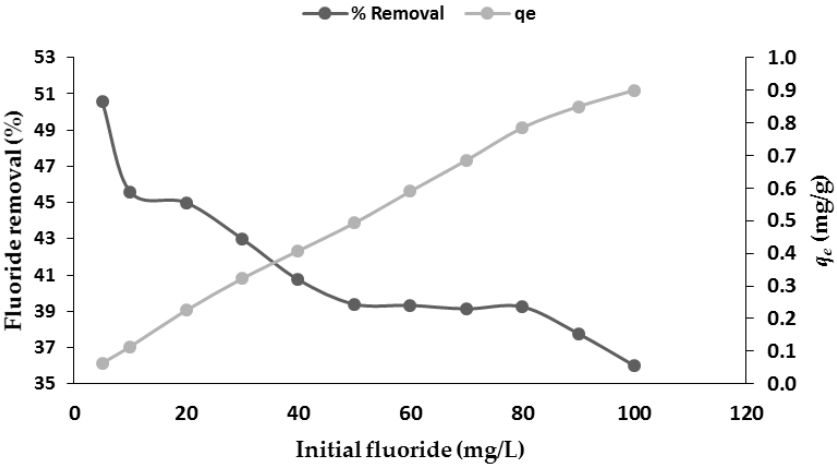
Figure 7. Fluoride removal and adsorption capacity against initial fluoride.